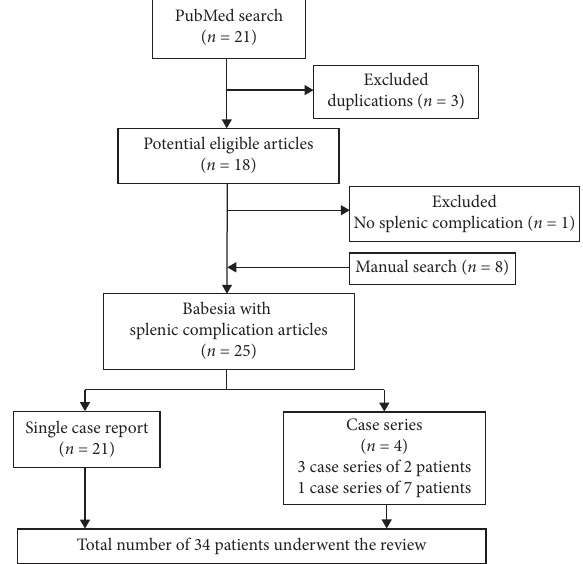
Figure 1: The flowchart delineates methodology and literature selection process according to PRISMA (Preferred Reporting Items for Systematic Reviews and